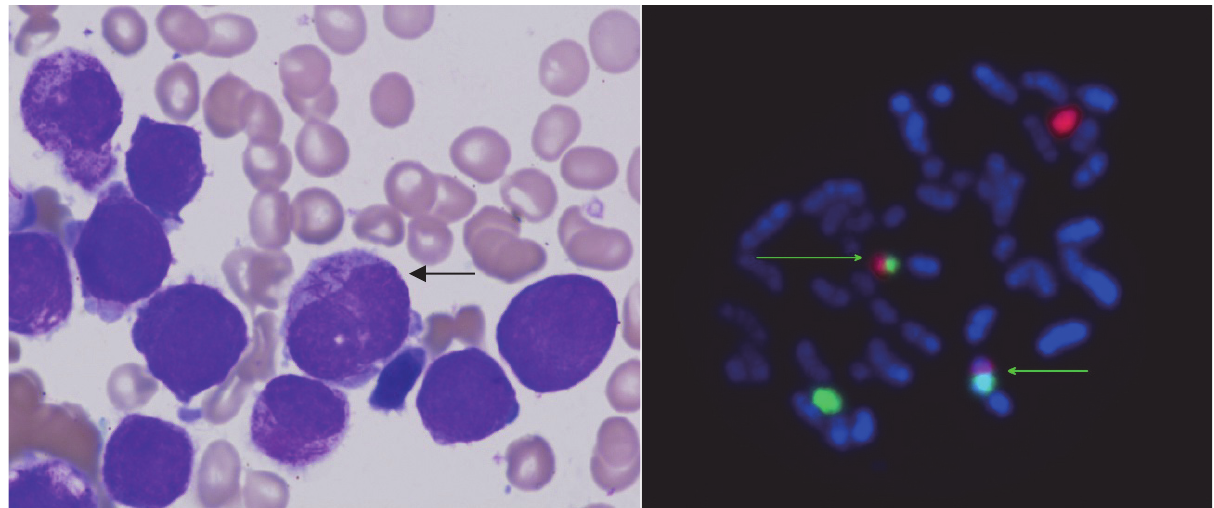
Fig. 1. Bone marrow aspirate showing diagnostic promyelocytes (left) and chromosomal translocation t(15;17)(q22;q21) diagnostic for APL (right).